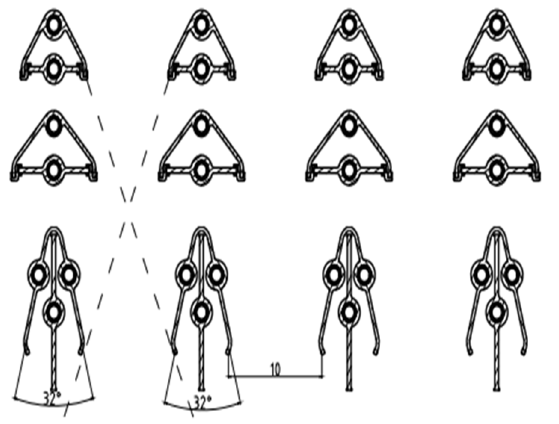
Figure 15. The structure of the cryosorption pump’s module versus α = 32°. The influence of α = 40°, 50°, 60°, 70°, 75°, 80°, 85°, 88°, 90°, 93°, 96°, 100°, 105° and